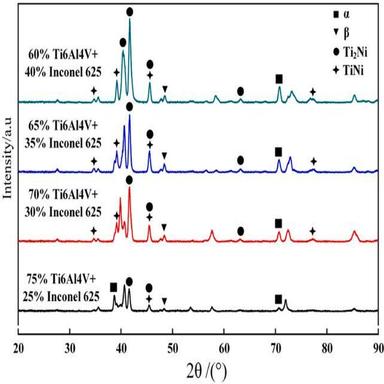
XRD results for deposition layers with different material ratios.